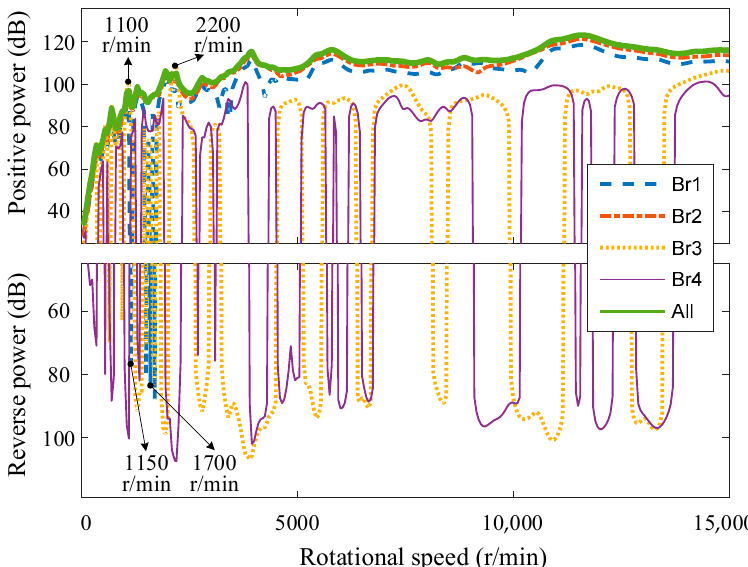
direction have less influence on the vibration.